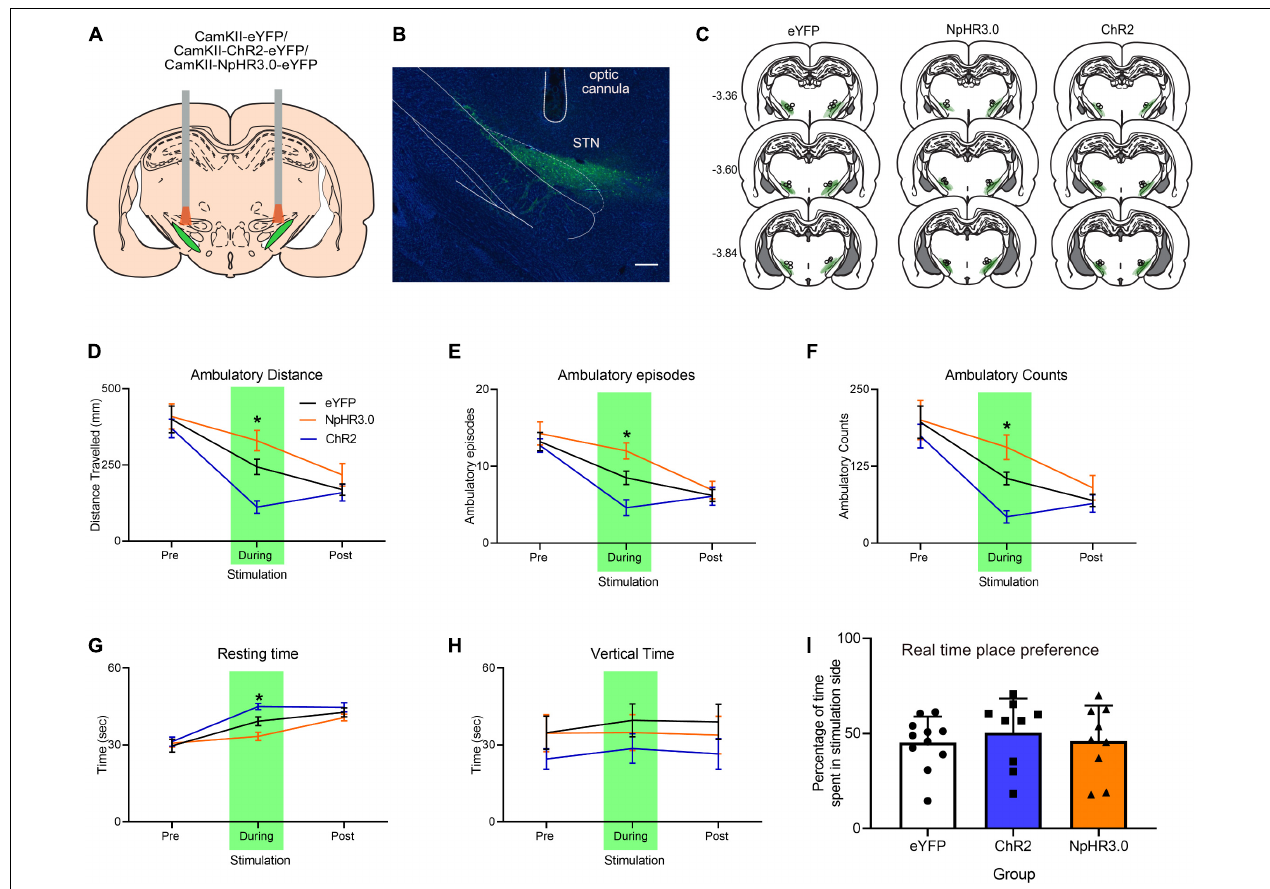
FIGURE 2 | Bidirectional regulation of motor control with optogenetic manipulation of the subthalamic nucleus. (A) Schematic bidirectional optogenetic manipulation subthalamic nucleus. (B) Representative immuno-histological image of eYFP expression in the STN and optic cannula placement, scale bar: 250 mm. (C) Placement of viral expression and optic cannula in the STN. Total of 3 min open field test involving pre, during, and post-stimulation periods, 1 min per phase showing (D) ambulatory distance, (E) ambulatory episodes, (F) ambulatory counts, (G) resting time, and (H) vertical time. (I) Graph showing real-time place preference. Data are expressed as mean ± SEM. * p <